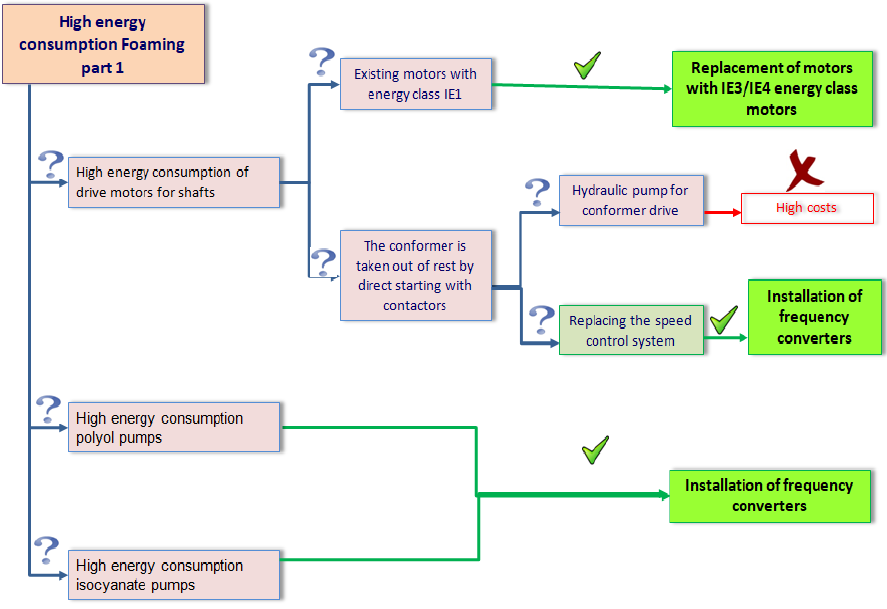
Figure 9. Solution analysis.